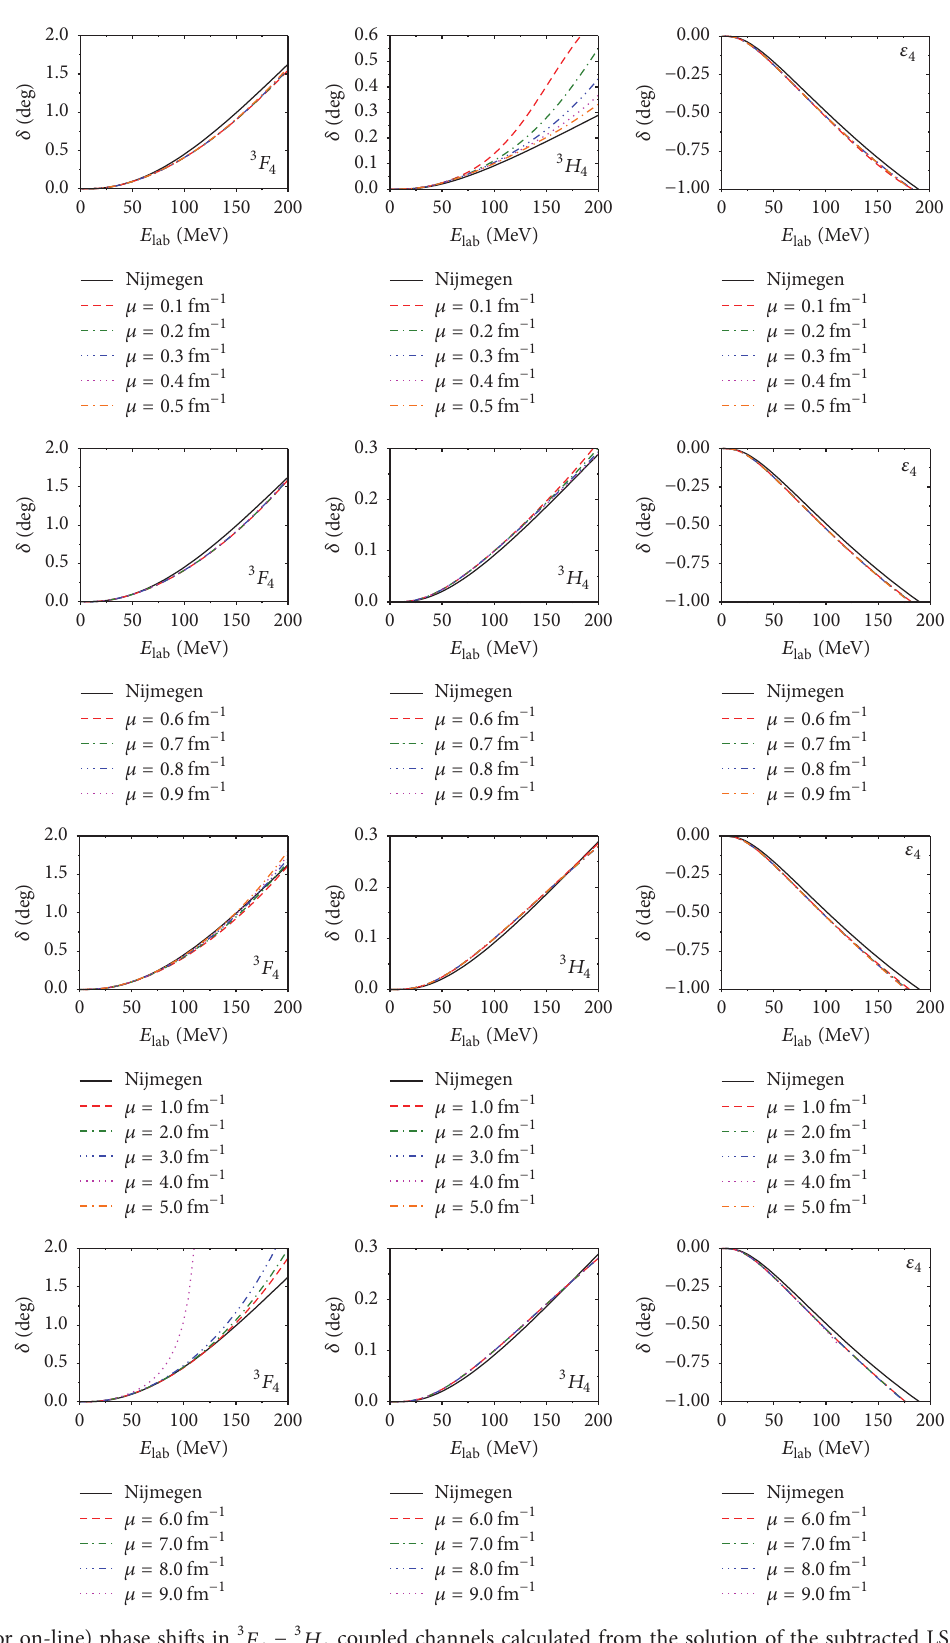
Figure 5: (Color on-line) phase shifts in 3 𝐹 4 − 3 𝐻 4 coupled channels calculated from the solution of the subtracted LS equation for the 𝐾 -matrix with five subtractions for the N3LO-EM potential for several values of the renormalization scale compared to the Nijmegen partial wave